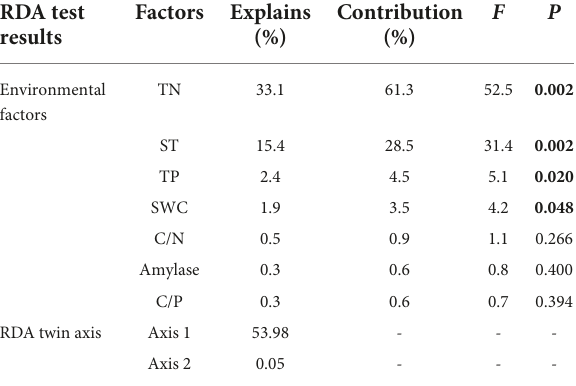
TABLE 6 Results of redundancy analysis (RDA) tests between soil carbon pools and environmental factors.